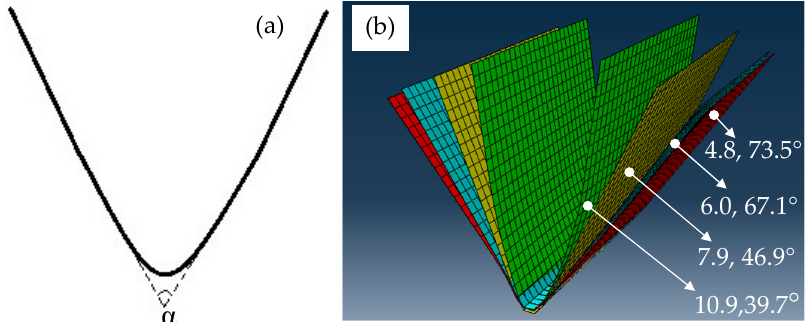
Figure 3. The springback angles of formed parts by prediction after thrice electrically-assisted forming at different average current densities: ( a ) Springback angle definition, ( b ) springback angles at different average current densities.